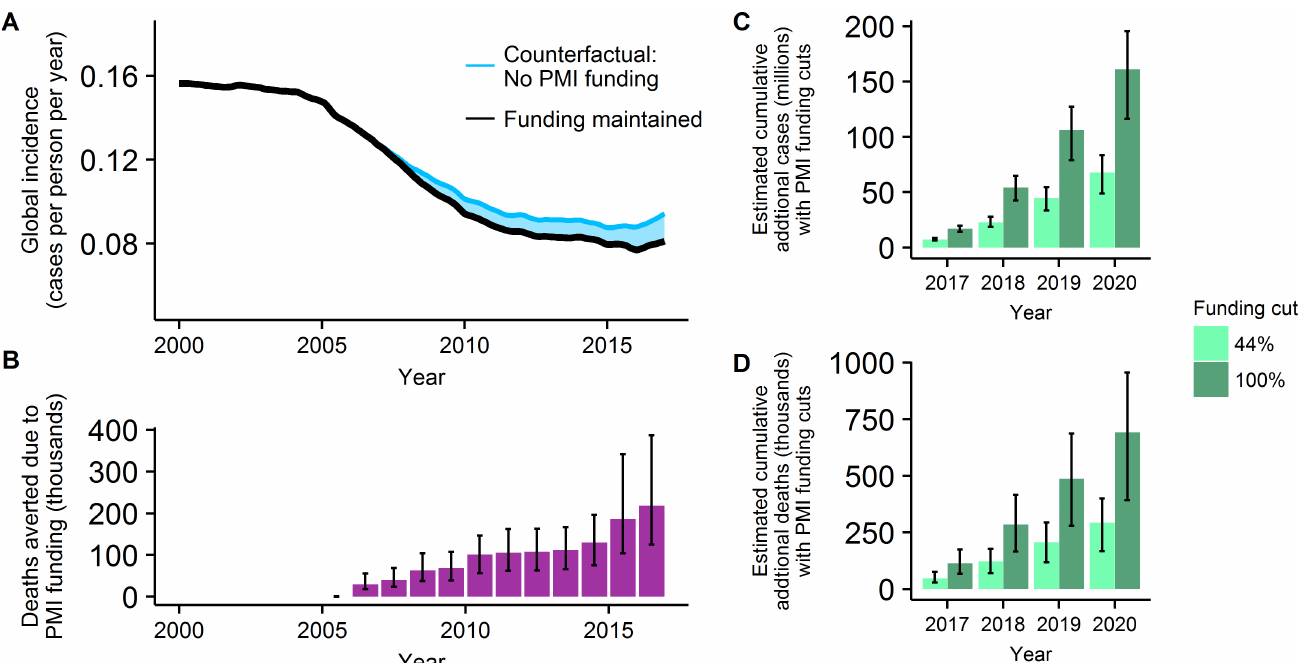
Fig 3. The projected impact of PMI funding on past and future global malaria trends. The (A) past trends (median estimates) in the global incidenceof P . falciparum malaria given fundingas occurred(black line) and estimate of the counterfactual trend had PMI support not existed (light blue line). The shadedarea represents the cases averted due to PMI fundingand (B) shows the associatedestimates of death averted each year due to PMI funding.Projected estimates of the additionalcumulativenumbers of (C) cases (and 95% CrI) and (D) deaths (and 95% CrI) that would occur if PMI fundingwas reducedby 100% (dark green bars) or 44% (light green bars) over the 4-year period2017–2020.PMI, President’sMalaria Initiative.